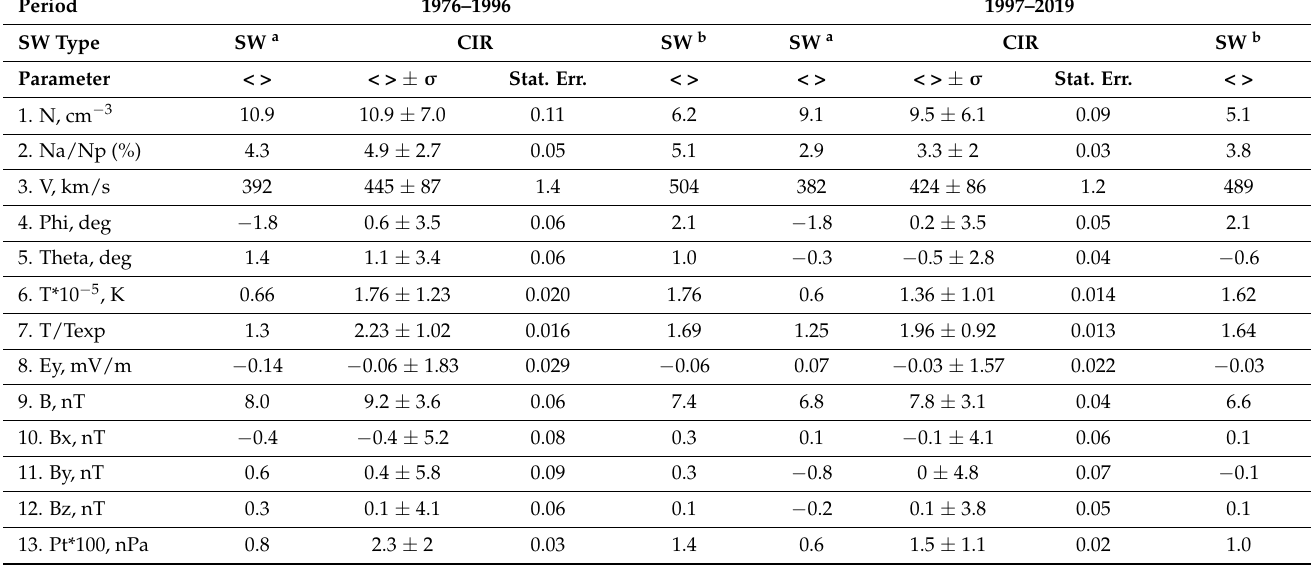
Table 1. Average parameters for sequence SW/CIR/SW (Figure